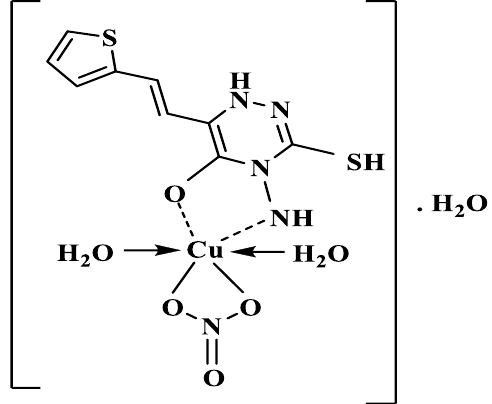
Figure 8. Chemical structure of [Cu(L)(NO 3 )(H 2 O) 2 ] . H 2 O complex. L represents AMT molecules with NH group.